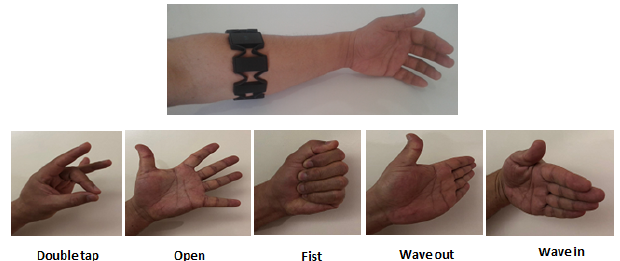
Figure 8. Myo armband with eight EMG sensors.